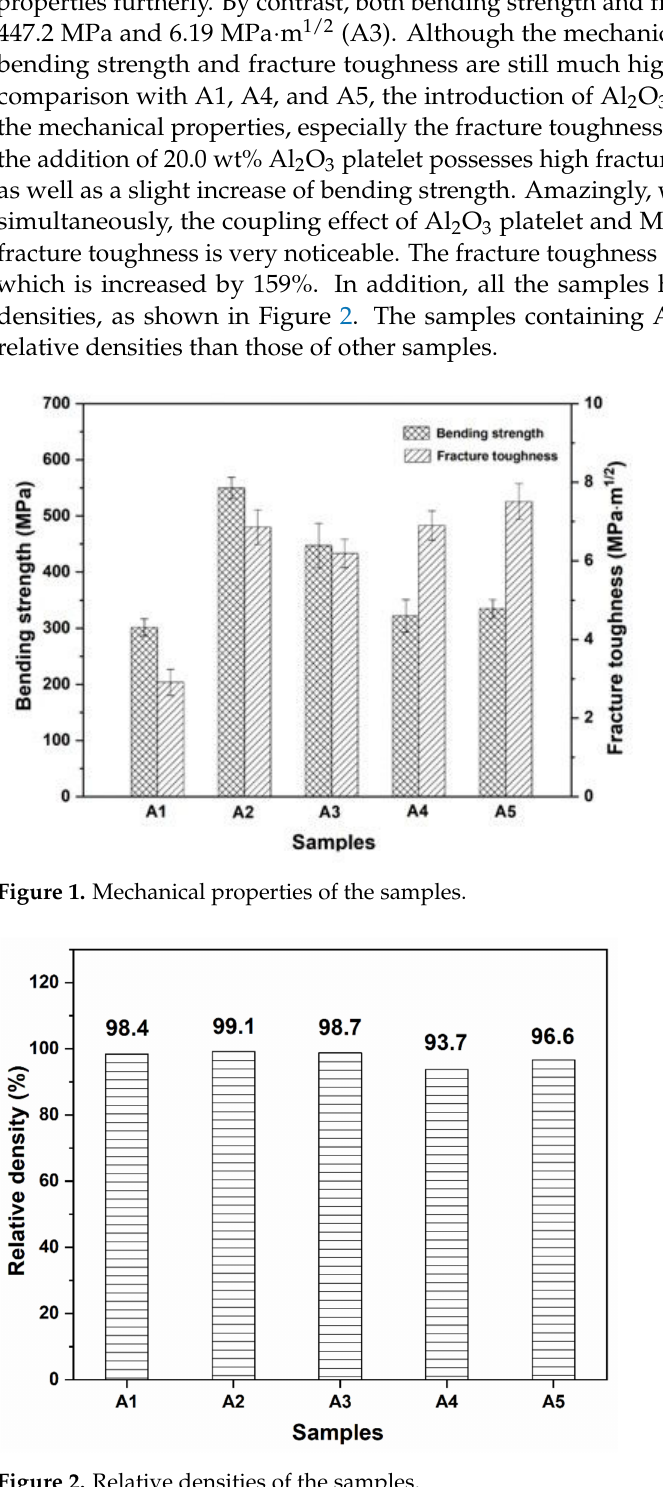
Figure 2. Relative densities of the